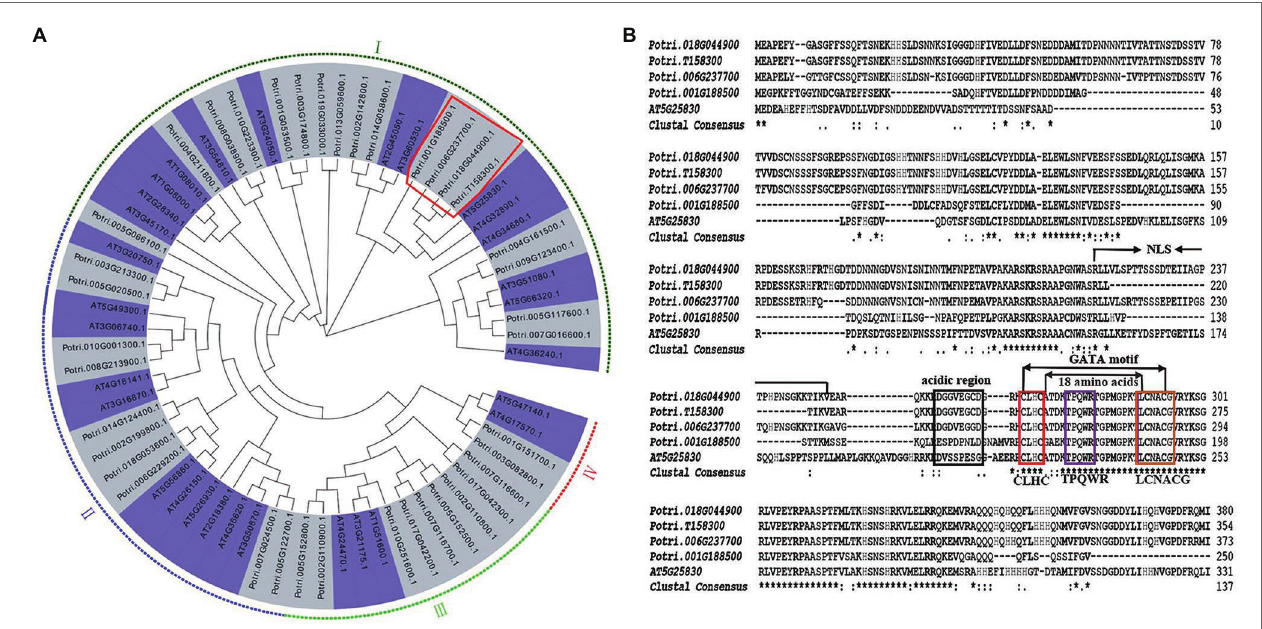
FIGURE 1 | Phylogenetic analysis and protein sequence alignment of PtrGATA12. (A) Phylogenetic analysis of PtrGATA12 with other GATA proteins in Populus trichocarpa and Arabidopsis thaliana . PtrGATA12 proteins were shown in a red rectangle. The tree showed four major phylogenetic subfamilies (subfamilies I to IV) indicated with different colored backgrounds. (B) AtGATA12 protein (AT5G25830) of A. thaliana was aligned with PtrGATA12 proteins from P. trichocarpa (Potri.001G188500, Potri.006G237700, Potri.018G044900, and Potri.T158300). The conserved CLBC, TPQWR, and LCNACG in GATA motif are indicated by red box, blue box, and brown box, respectively; NLS, the putative domains for nuclear localization signals; the boxed region indicates the putative activation